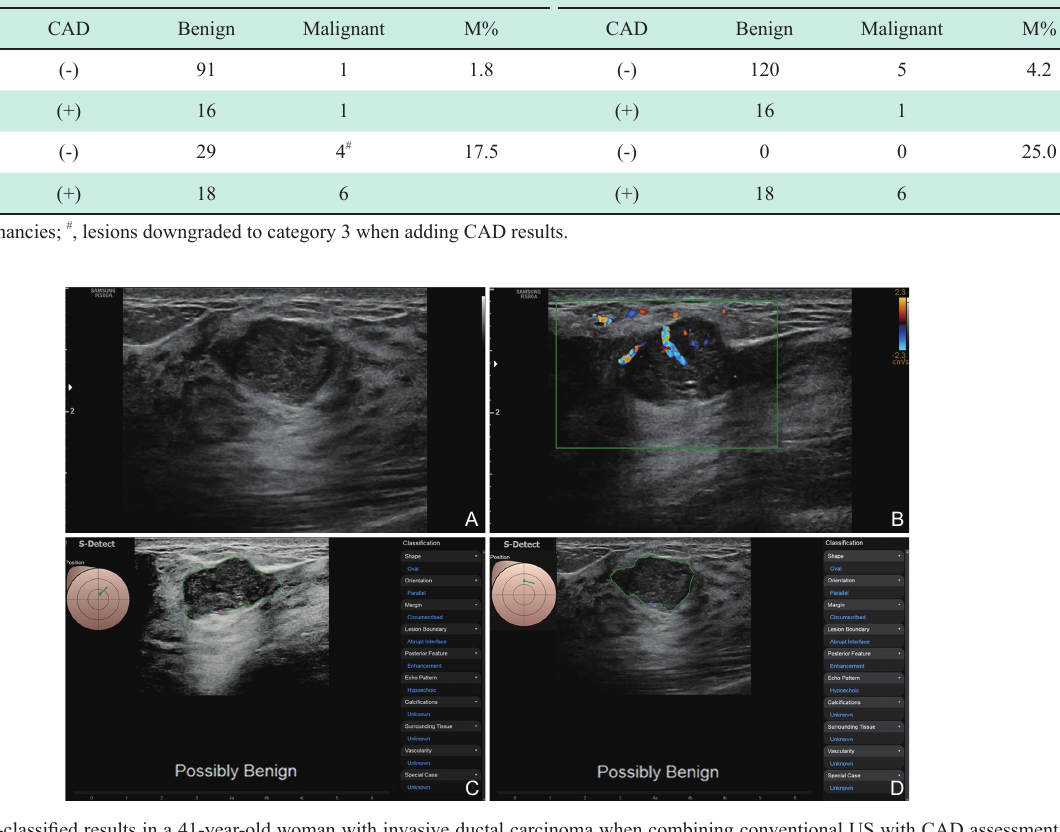
Table 4 Distribution of category 3 and 4a lesions analyzed by experienced radiologists and CAD results: before and after adding CAD results according to Method 1 ( n =166) BI-RADS category